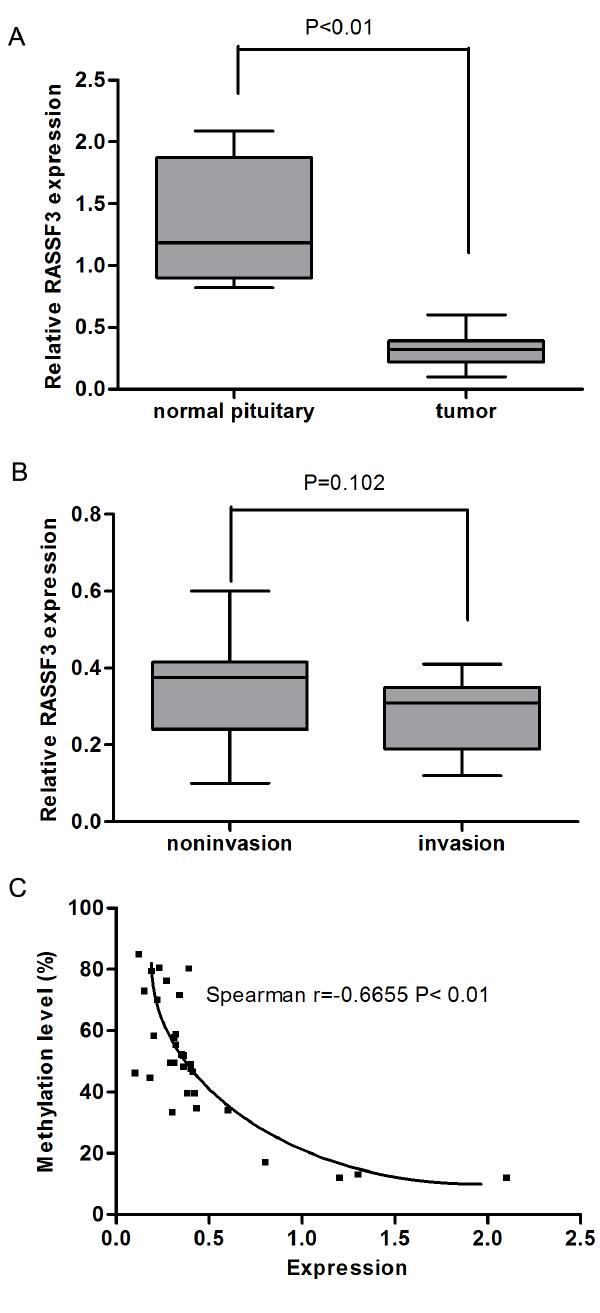
Figure 2. RASSF3 downregulation correlates with its promoter hypermethylation in human somatotroph adenomas. (A) The average relative RASSF3 mRNA level in 4 normal samples and 27 tumor samples is shown. RASSF3 expression level was significantly lower in human somatotroph adenomas than in normal pituitary samples (P , 0.01). (B) There was no significant difference in RASSF3 methylation and expression levels between different tumor grades. (C) Spearman analysis of all normal and tumor samples with RASSF3 mRNA level and promoter region methylation level demonstrated a significant inverse correlation ( r =–0.6655) between DNA hypermethylation and gene expression.